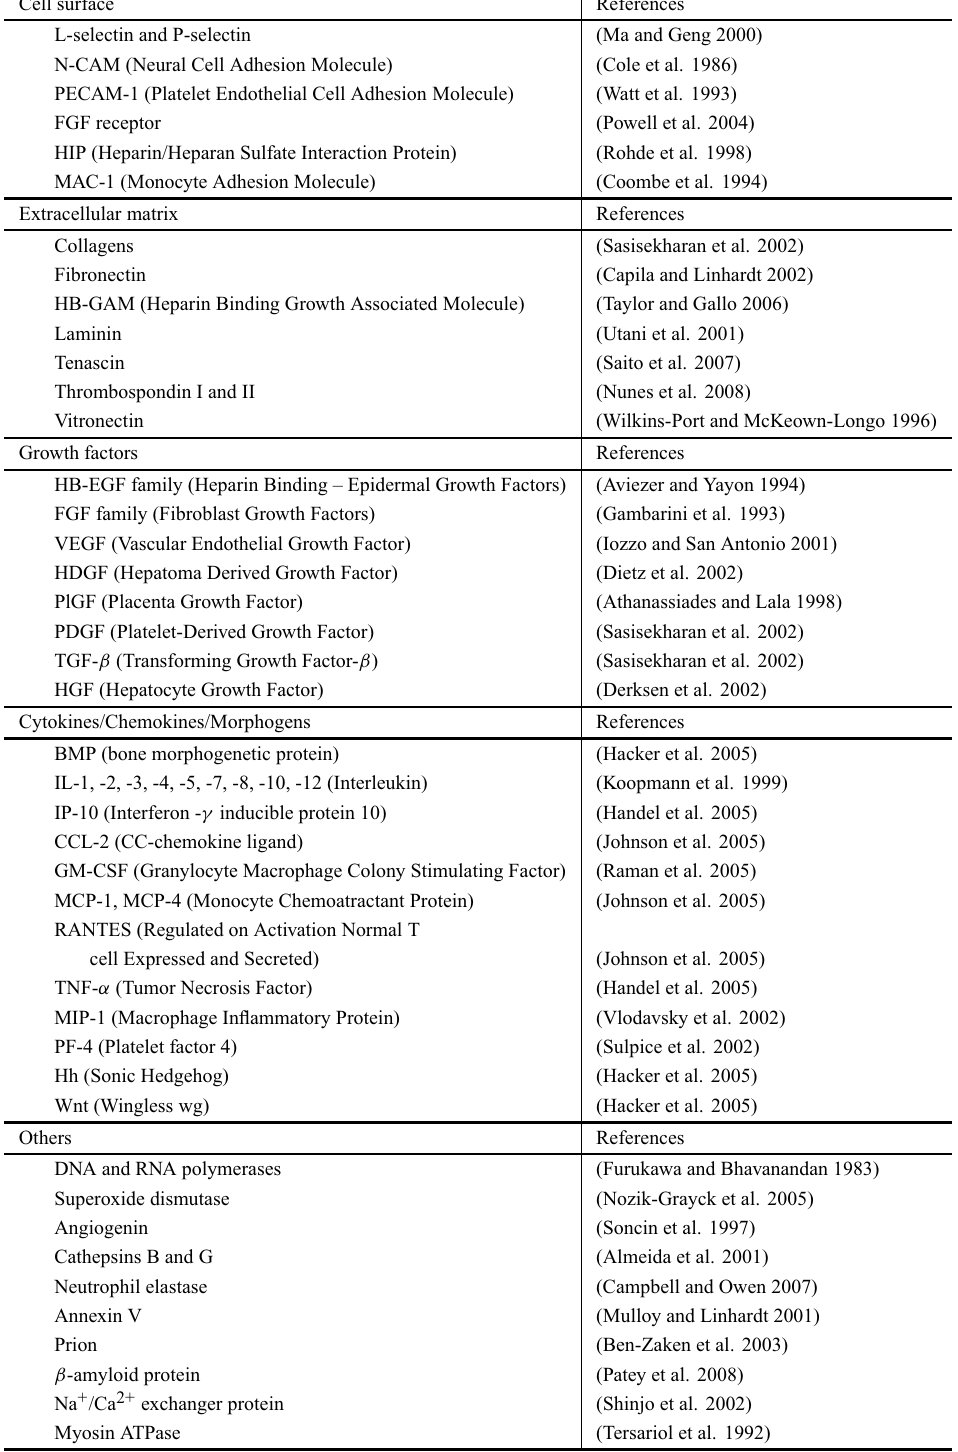
Heparan sulfate binding